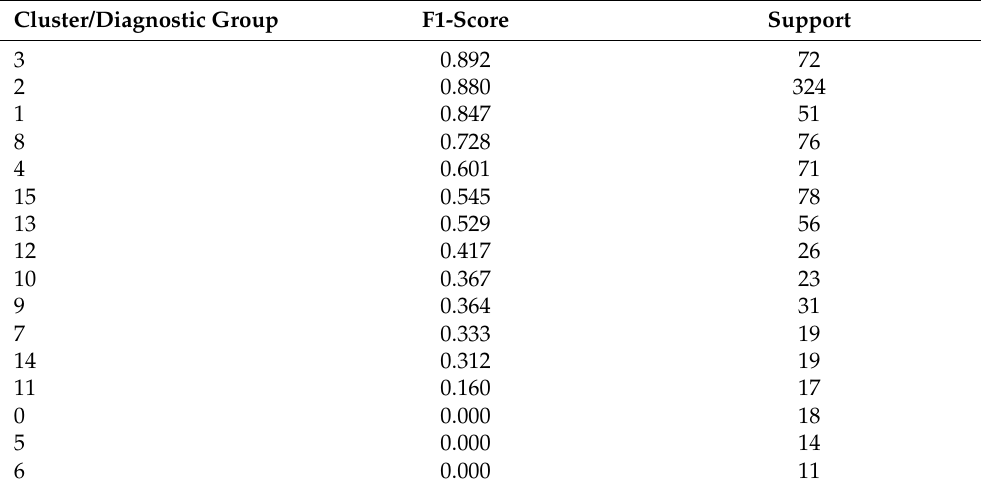
Table 5. Classification performance of the Patho-BERT-classifier, predicting the HDBSCAN